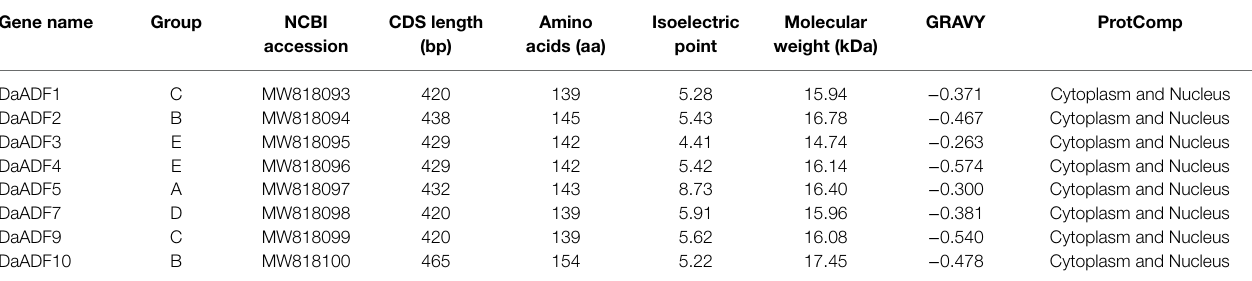
TABLE 1 | Detailed information of 8 actin-depolymerizing factor (ADF) family genes identified in this